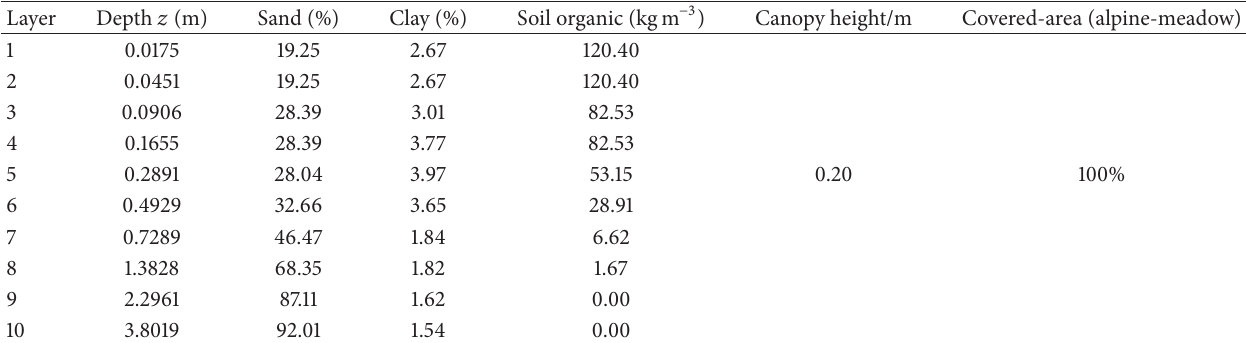
Table 2: Same as Table 1, but ZS